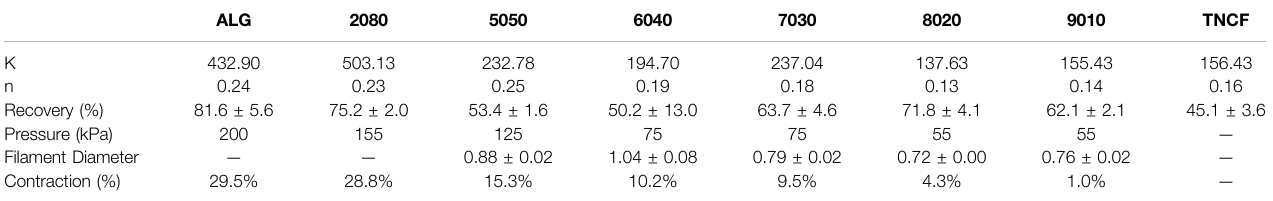
TABLE 4 | Fitted Power-Law parameters, thixotropy recovery rate, printing pressure, fi lament diameter, and contractility after crosslinking. ALG